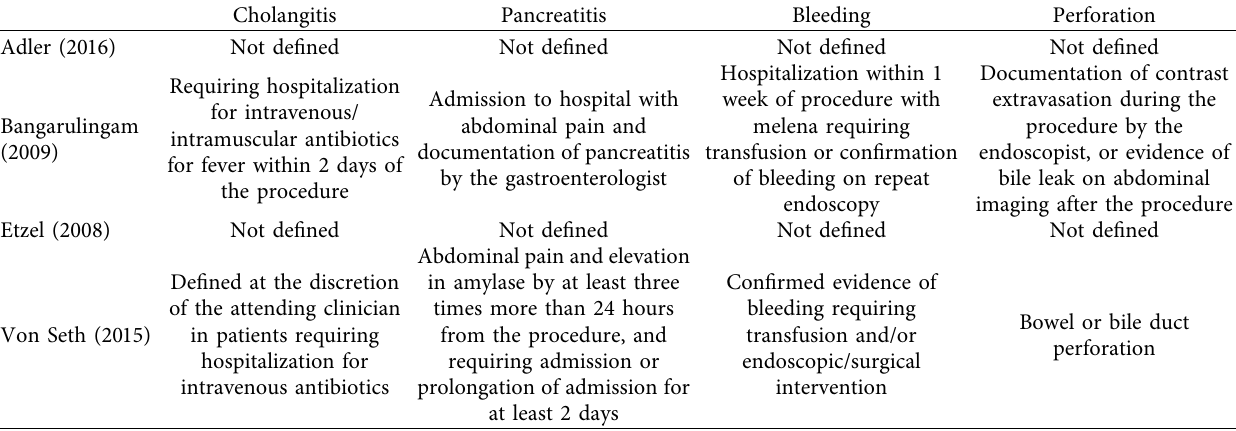
Table 1: Definition of ERCP-related adverse